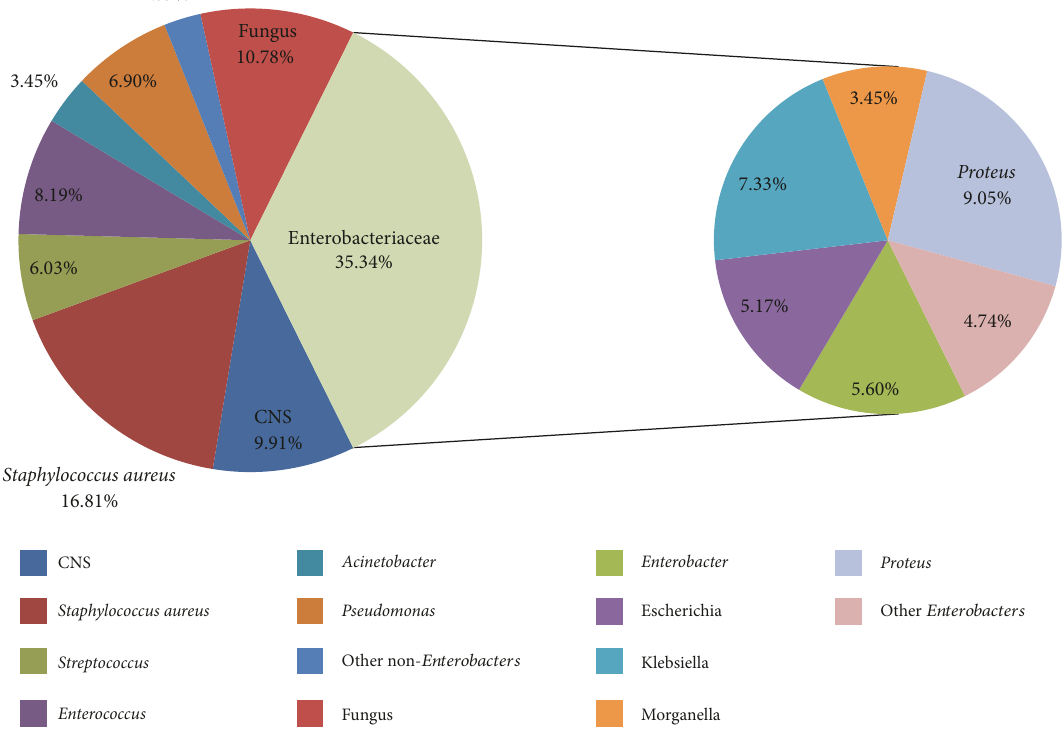
Figure 1: Distribution of the 207 bacteria